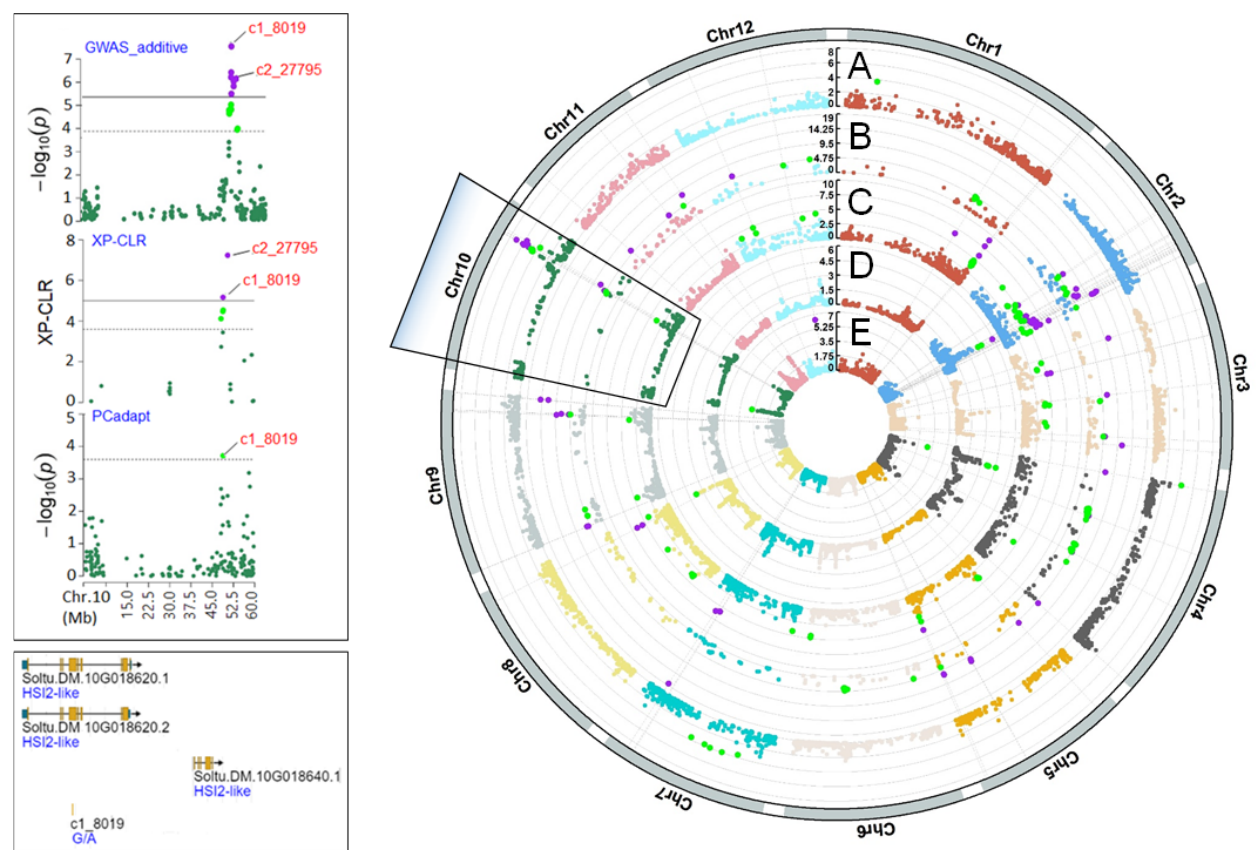
Figure 4. Circular Manhattan plots of the global distribution of association signals or selection signatures across the genome for the populations under study. The circles from outside to inside illustrate: ( A ) − log 10 ( p ) of GWAS using additive model for strata ‐ corrected 190 ‐ line case ‐ control diversity panel, ( B ) XP ‐ CLR scores from a genome ‐ wide scan for the 227 ‐ line diversity panel consisting of chip processing as the object population and non ‐ chip ‐ processing clones as the reference population. ( C ) − log 10 ( p ) of PCAdapt for the 227 ‐ line diversity panel, ( D ) − log 10 ( p ) of XP ‐ EHH for two populations of the 227 ‐ line diversity panel, and ( E ) − log 10 ( p ) of iHS for chip ‐ processing population. Values for GWAS_additive test and XP ‐ CLR test surpassing the threshold ≥ 5 are highlighted in purple. Values for each test between 5 ≥ the threshold ≥ 3.7 (the threshold 3.7 was set based on the Benjamini–Hochberg procedure (method = “BH”) using 1% as false discovery rate (FDR) threshold for PCAdapt) are highlighted in green. The Circular Manhattan plot was created using the R package CMplot (https://github.com/YinLiLin/CMplot (accessed on 12 June 2022)). Each SNP is plotted according to its chromosomal location ( x axis) and its − log 10 ( p ) values or XP ‐ CLR score ( y axis) from the five genomic scan approaches. On the left side is shown regional association plot for the HSI2 ‐ like locus containing the lead SNP c1_8019 on chromosome 10 for the three ap- proaches (GWAS_additive, XP-CLR and PCAdapt) from a rectangular part of the Circular Manhattan plots. The lead SNP c1_8019-containing the gene models (two isoforms, Soltu.DM.10G018620.1 and Soltu.DM.10G018620.2) and the other locus (Soltu.DM.10G018640.1) just next to it are shown on the left